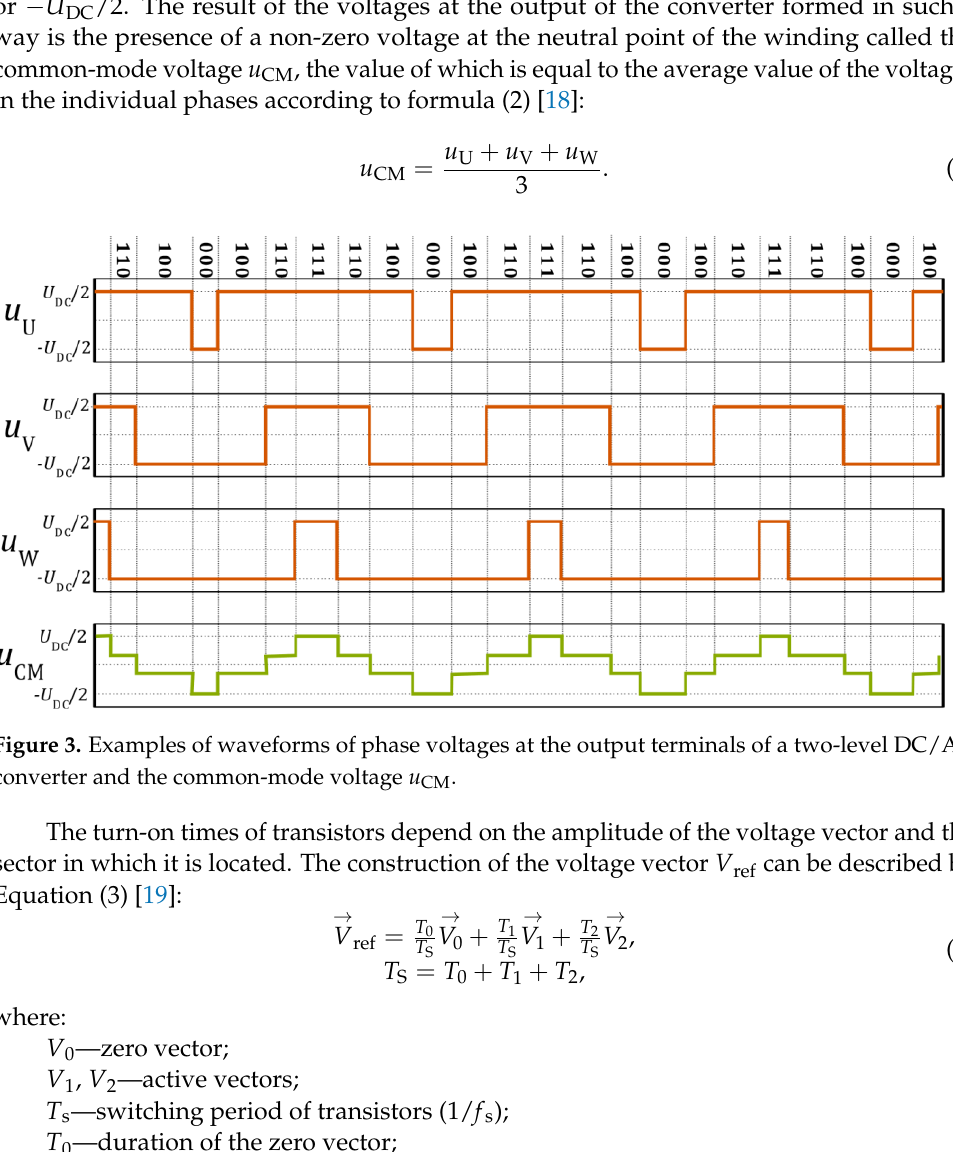
Figure 2. Diagram of a two-level DC-AC converter ( a ) and transistor switching combinations ( b ).